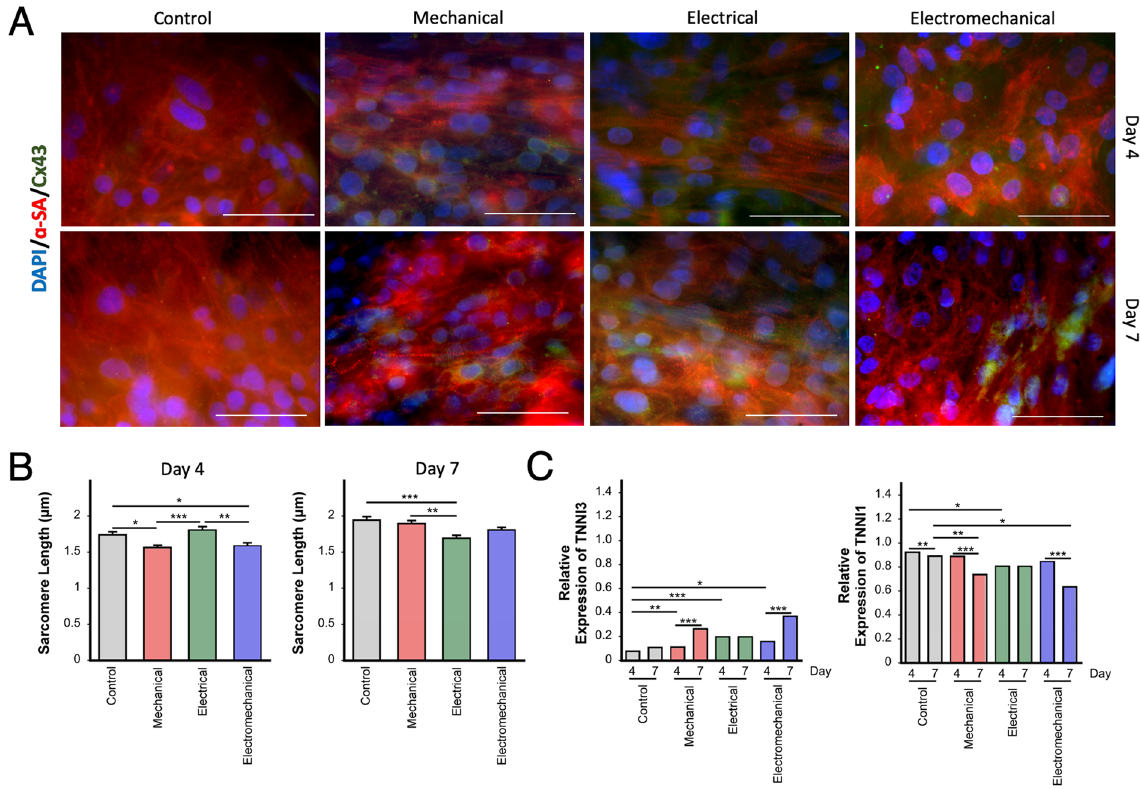
Figure 2. Effect of stimulation on hiPSC-derived cardiomyocyte cultures. ( A ) Representative immunofluorescent images of hiPSC-derived cardiomyocytes cultured on flexible silicone membranes under either no stimulation (control), mechanical stimulation, electrical stimulation, or mechanical and electrical stimulation at different time points (4 and 7 days). Cells were stained for α -sarcomeric actin ( α -SA; red) and connexin-43 (Cx43; green). Nuclei were stained using DAPI (blue). Scale bars = 50 µ m. ( B ) Effect of stimulus on sarcomere length measured at 4 and 7 days (n = 2). Values calculated from the measurement of 100 random cells over 6 different fields of view. ( C ) Relative gene expression for TNNI1 and TNNI3 measured for hiPSC cells cultured for 4 and 7 days without and with the different stimulation regimes (n = 3). * p < 0.05, ** p < 0.01, and *** p < 0.001 calculated using One-way ANOVA with Tukey posthoc